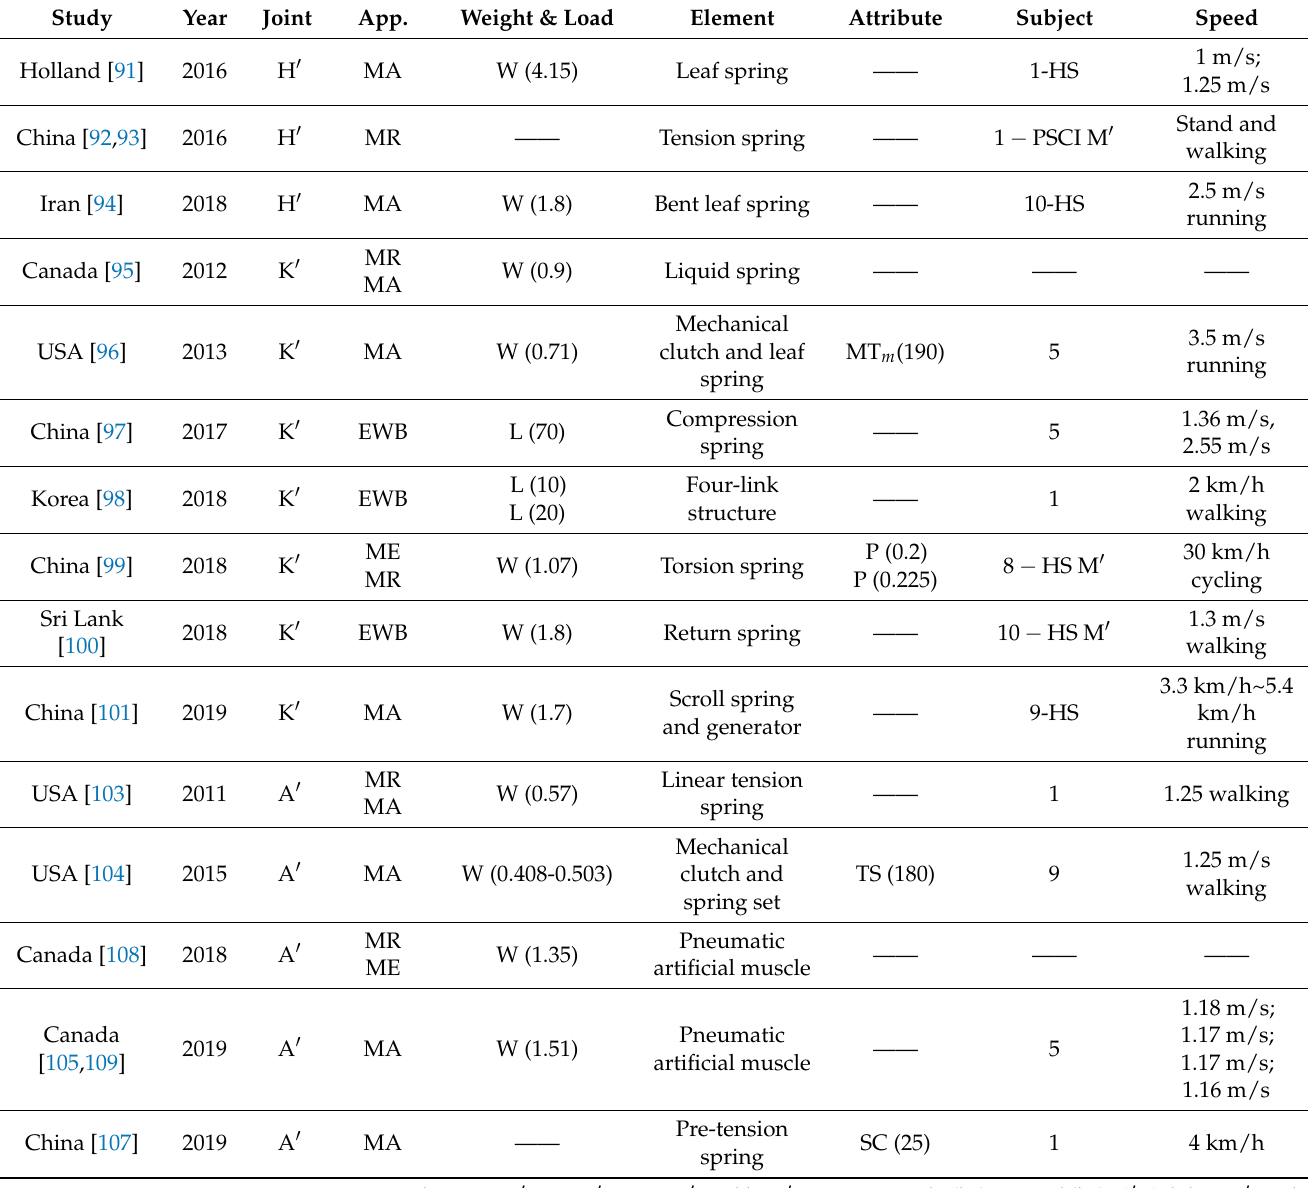
Table 5. Unpowered lower limb single-joint assisted exoskeletons.